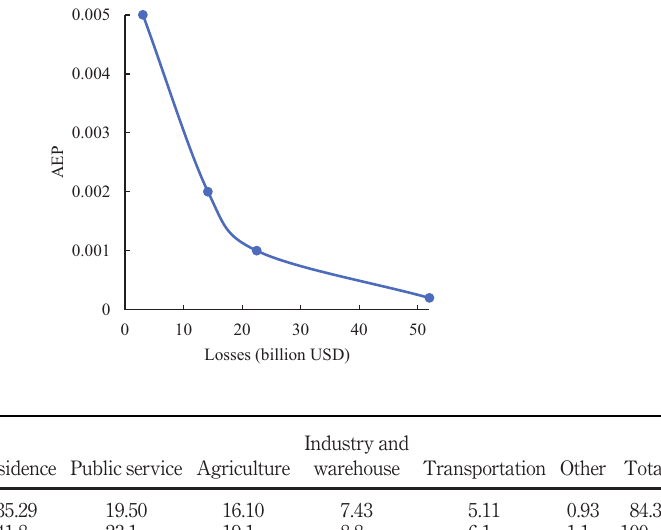
Figure 5. Flood damage-AEP curve